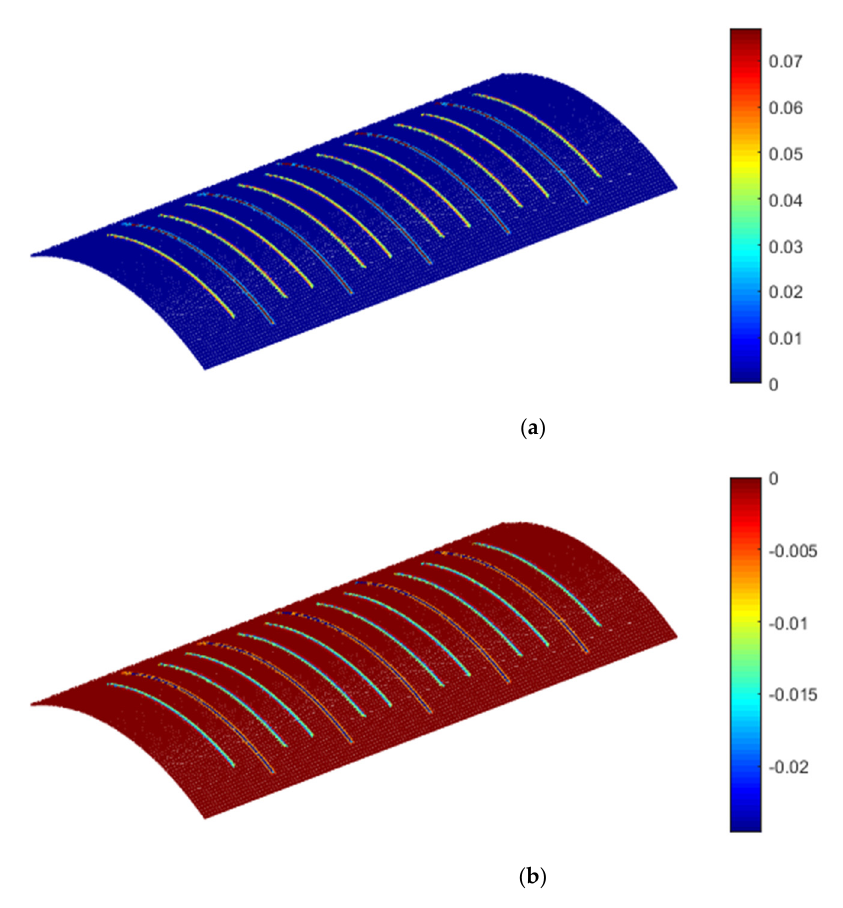
Figure 9. Heating paths applied to experimental case.